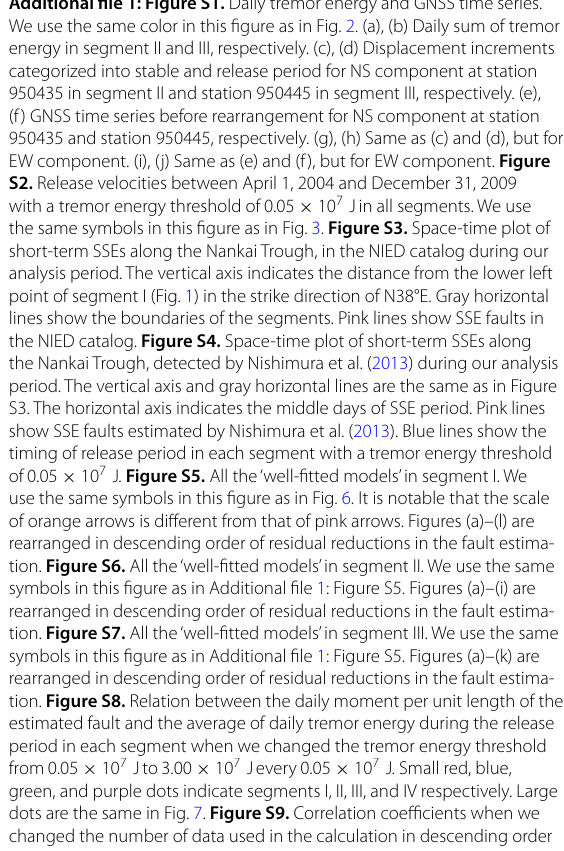
tion. Figure S7. All the ‘well-fitted models’ in segment III. We use the same symbols in this figure as in Additional file 1: Figure S5. Figures (a)–(k) are rearranged in descending order of residual reductions in the fault estima- tion. Figure S8. Relation between the daily moment per unit length of the estimated fault and the average of daily tremor energy during the release period in each segment when we changed the tremor energy threshold from 0.05 × 10 7 J to 3.00 × 10 7 J every 0.05 × 10 7 J . Small red,